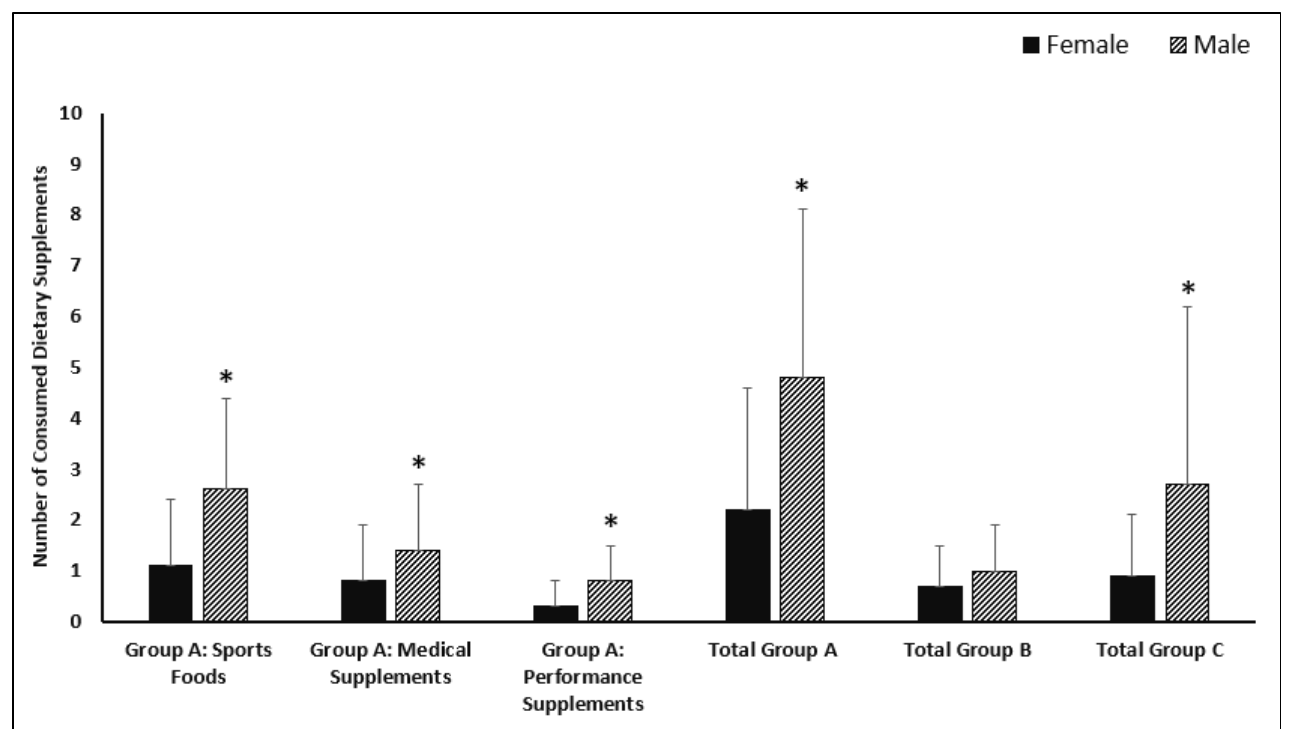
Figure 1. DS consumption in Turkish footballers by sex according to AIS classification [12]. * Statistical differences between males and females ( p < 0.05).